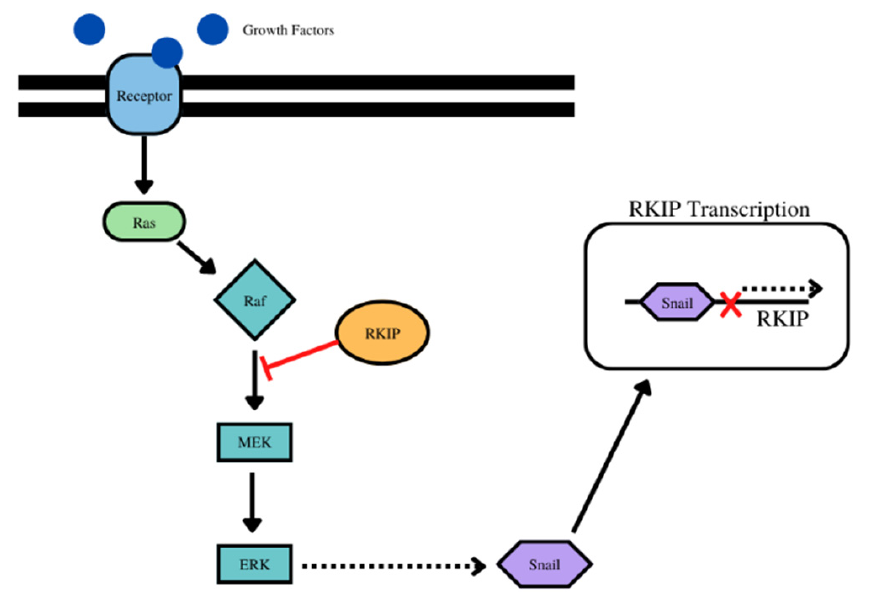
Figure 1. Crosstalk Between RKIP and Snail. RKIP inhibits the MEK/ERK signaling pathway by interrupting the interaction between Raf and MEK, stopping the progression of the signal through the pathway. Snail is regulated downstream of the MEK/ERK pathway, upregulated through MEK/ERK signaling. In addition, Snail is an inhibitor of RKIP transcription through binding to the promoter region of RKIP.